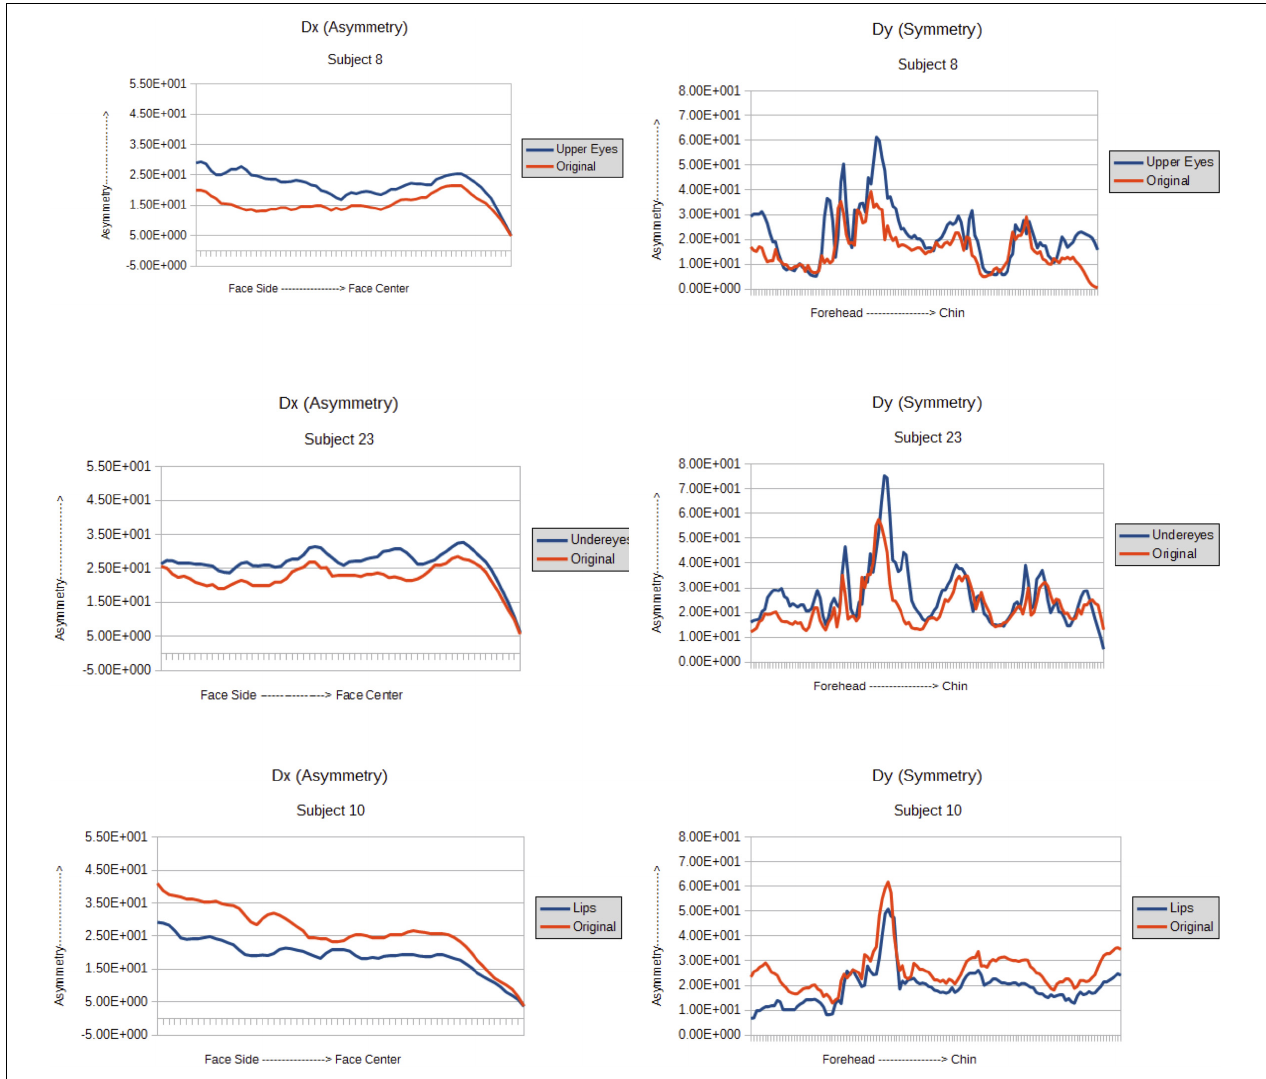
FIGURE 4 | Left : D x values from 3 subjects with the three different types of makeup – upper eyes, under eyes, and lips. Right : D y values from 3 subjects with under eye